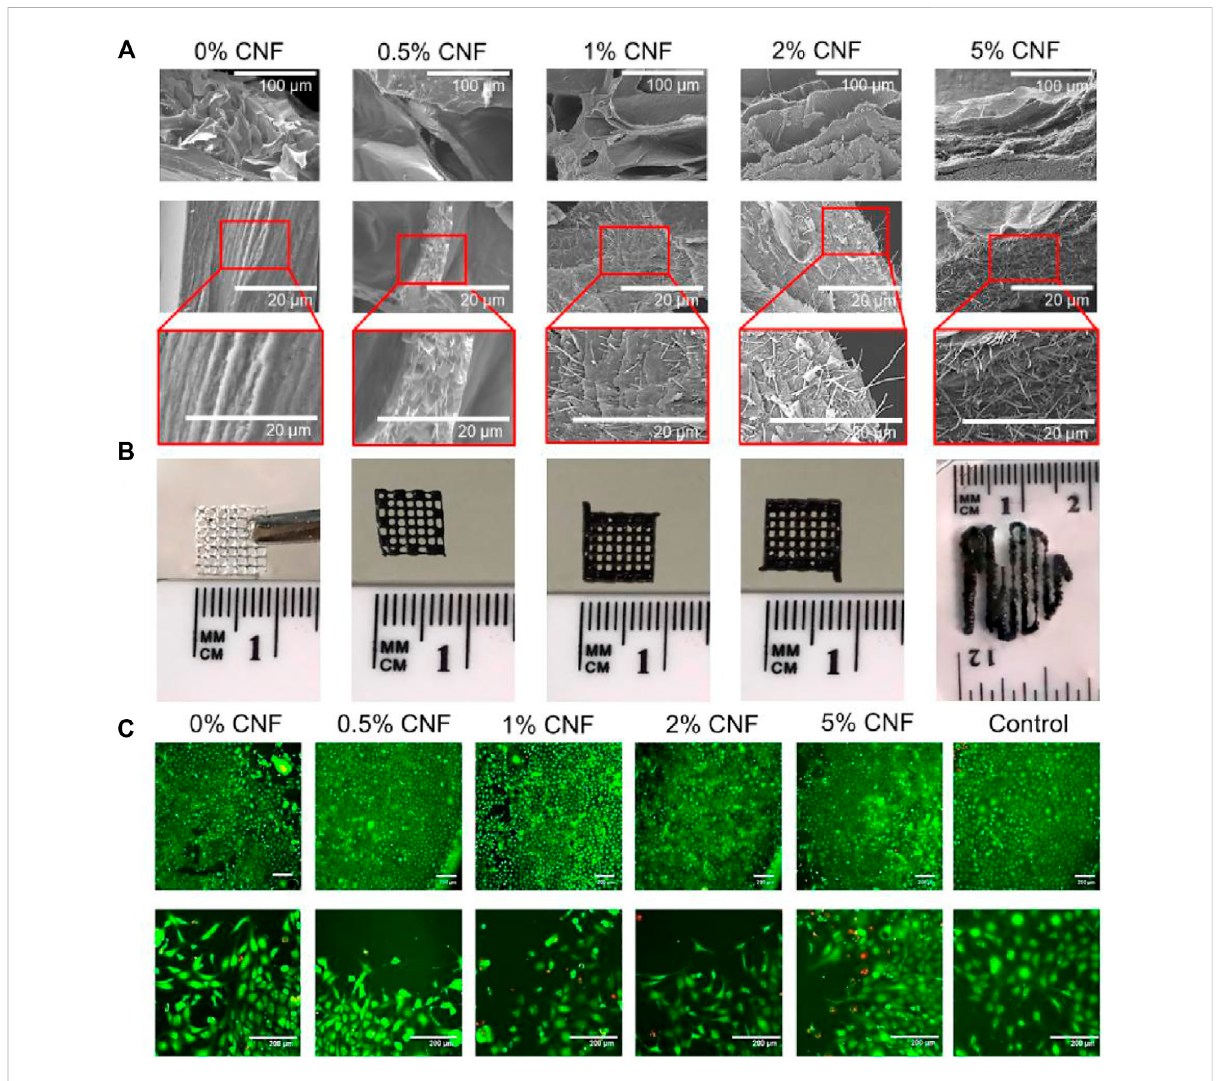
FIGURE 6 (A) SEM images oflyophilisedhydrogels with different CNFscontent. (B) Imagesof3Dprinted latticesusingalginate/gelatin/CNF hydrogels. (C) LIVE-DEAD assay. For all tests NIH/3T3 cells were cultured in the presence of the alginate/gelatin/CNF hydrogels over a period of 96 h. Reproduced with permission from ref (Sera fi n et al.,